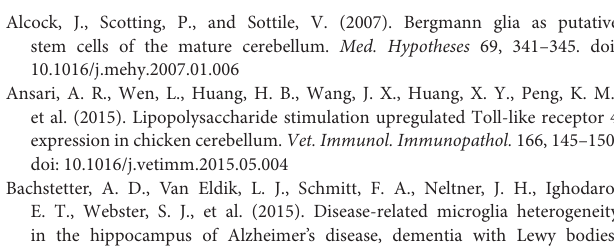
Figure S1 | Genotyping of TLR4 − / − and WT mice. Offspring from the TLR4 ± intercross were genotyped. PCR amplification was carried out using tail genomic DNA from WT (lane 1), TLR4 ± (lane 2), and TLR4 − / − (lane 3) mice; H 2 O (lane 4) was used as a control. Figure S2 | Loss of TLR4 has no effect on muscle strength. (A) TLR4 − / − and WT mice showed similar limb strength, as measured by the traction test. (B) Limb strength was evaluated with the hangwire test and was comparable between TLR4 − / − and WT mice. (C) TLR4 deficiency had no effect on body weight. Data are presented as mean ± SEM ( n = 9 –12 mice/group). Figure S3 | TLR4 is expressed in the PL of the cerebellum and in a small number of microglia. (A) Immunohistochemical analysis revealed no TLR4 expression in the PL of TLR4 − / − cerebella. (B) Weak fluorescence in other layers was attributed to background immunoreactivity. (C) TLR4 expression was also detected in Iba1-positive microglia, as shown by arrows in the high-magnification image (D) . Scale bar = 100 µ m in (A,B) , 25 µ m in (C) , 10 µ m in (D) . TLR4 Ab, TLR4 antibody. Figure S4 | TLR4 deficiency has no effect on GC and microglia numbers. (A) NeuN-expressing GCs in the GCL, with a high-magnification image (A ′ ) . (B) Quantitative analysis of GC density revealed no difference between the two groups. (C) Iba1-positive microglia localized in the ML and GCL in both TLR4 − / − and WT mice. Microglia morphology was similar between the two groups, as shown in the high-magnification image (C ′ ) . (D,E) Quantitative analysis of cerebellar microglia showed no difference in microglia number (D) or percent area of microglia (E) between the two groups. Scale bar = 100 µ m in (A,C) , 25 µ m in (A ′ ,C ′ ) . Data are presented as mean ± SEM ( n = 3 mice/group). Video 1 | Performance in the accelerating -rotarod test. TLR4 − / − mice (right) tended to bend down and stay close to the rod as compared to WT mice, which stood on the rod with head toward the front (left) during rod acceleration. Step frequency was higher in mutants than in WT mice. Video 2 | Hindlimb clasping posture in the hindlimb clasping test. TLR4 − / − mice (right) showed typical hindlimb clasping posture, whereby both hind-limbs were fully clasped and touching the abdomen after an initial period in which their hind-limbs were splayed outwards away from the abdomen, which was accompanied by body torsion. WT mice (left) exhibited a normal hindlimb extension reflex but maintained this position, with hind-limbs splayed outwards away from the abdomen, splayed toes, and constant body torsion. These results suggest cerebellar ataxic-like behavior in mutants. Video 3 | Impaired motor coordination in the beam walk test. TLR4 − / − mice (right) walked slowly and exhibited frequent limb slips on the beam as compared to WT mice (left). Mutants had difficulty maintaining their hind-limbs on the beam and clasping it while walking forward. Video 4 | Limb placement and forward movement in the ledge test. TLR4 − / − mice (right) placed their limbs close to the side walls of the ledge instead of on the ledge surface like WT mice (left) when walking along the ledge. TLR4 − / − mice exhibited a slower walking pace and showed a greater number of limb slips than WT